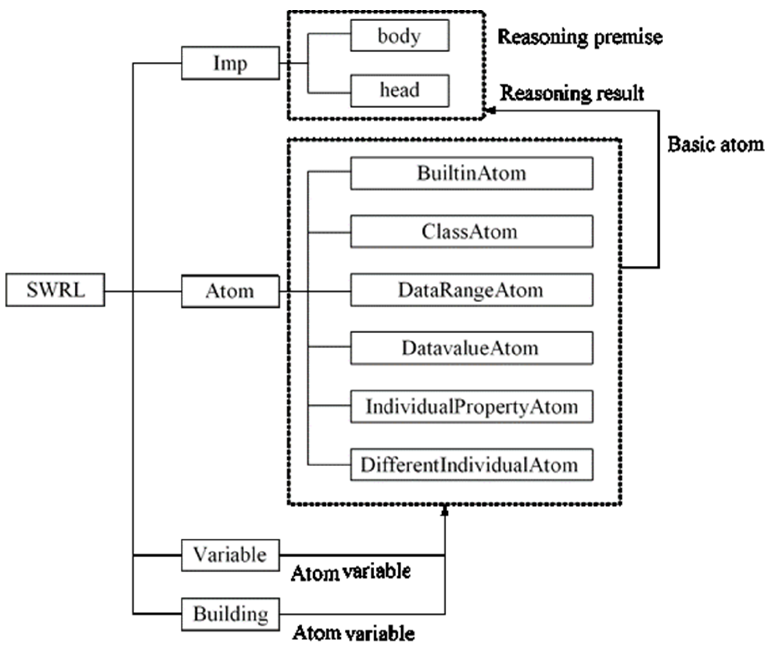
Figure 5. SWRL Figure 5. SWRL framework.